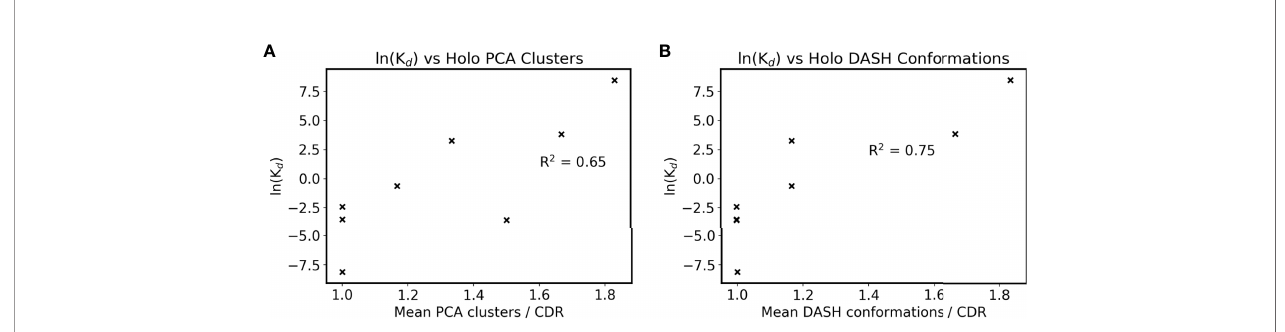
FIGURE 4 | Antigen bound CDR sampling and af fi nity. The mean number of (A) holo PCA clusters and (B) holo DASH conformations across all six CDRs is plotted for each antibody. Note that two points overlap in sub fi gure B at ln(K d ) = -3.5. ln(K d ) is used as a proxy for af fi nity due to the Gibbs free energy equation of D G° = -RTln(K eq ), and natural logarithms of K d values in nM are used (see Table 1